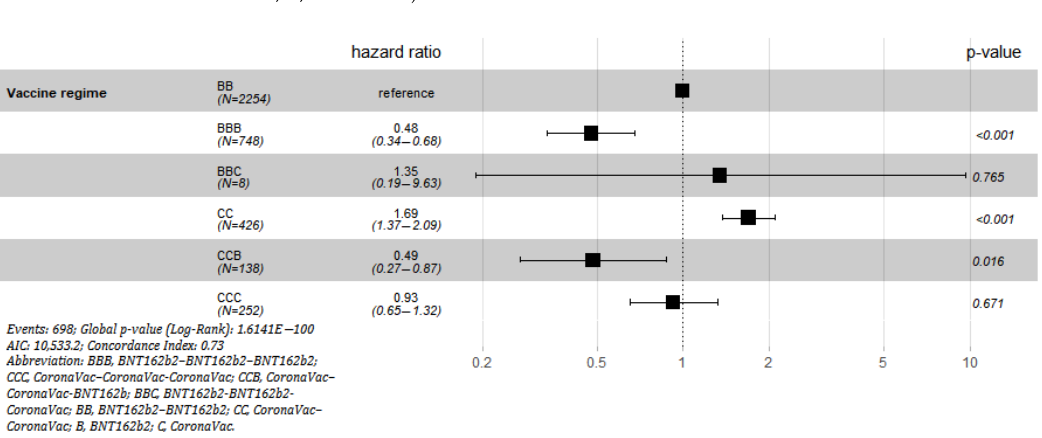
Figure 2. Hazard ratio for COVID-19 and associated 95% confidence interval for different vaccine